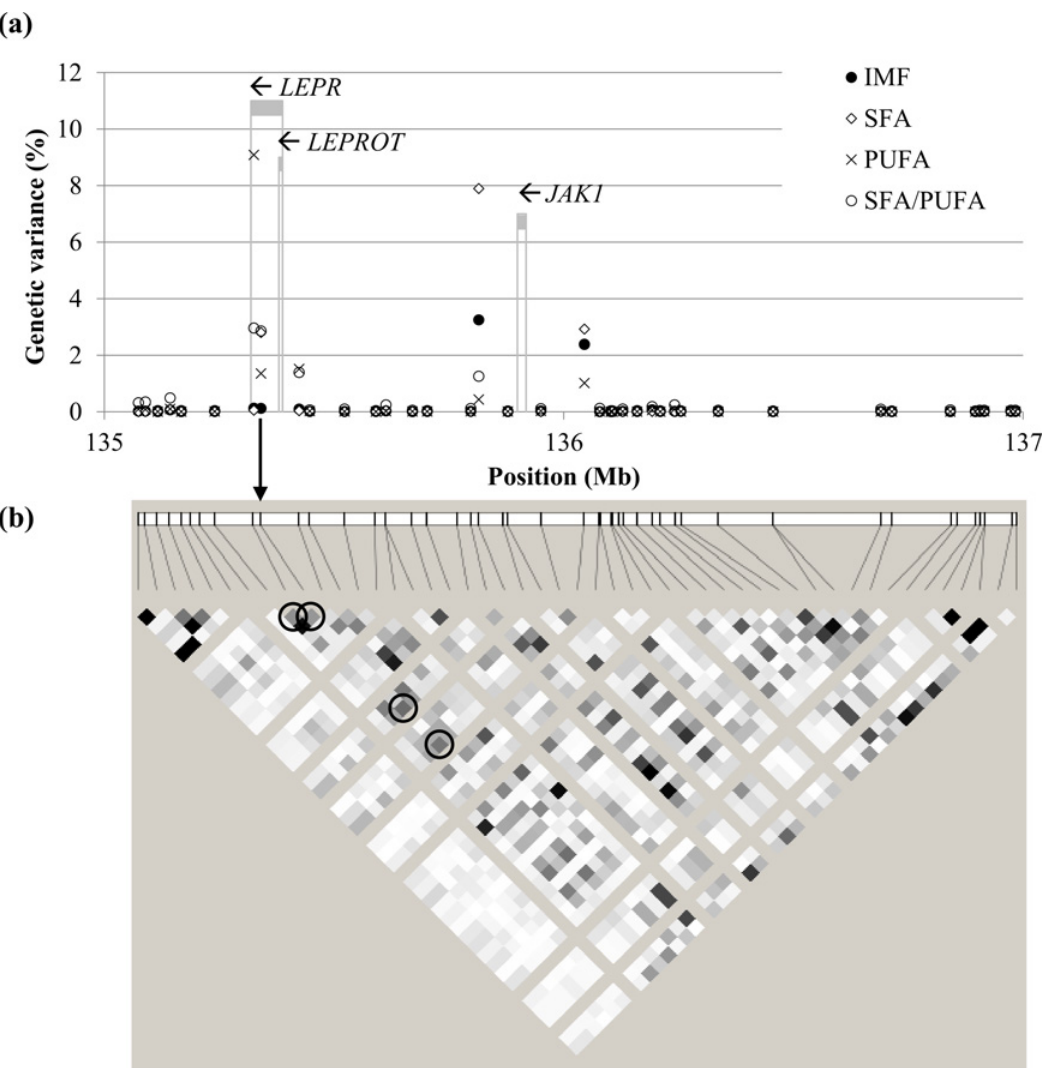
Fig 4. Individual markers in the SSC6 at 135 – 137 Mb region. Panel (a) shows the percentage of genetic variance explained for intramuscular fat content (IMF), saturated fatty acids (SFA), polyunsaturated fatty acids (PUFA), and SFA/PUFA of muscle gluteus medius . The SNP NM_001024587: c . 1987C > T in exon 14 of LEPR , indicated with an arrow, is not provided in the chip. Grey stripes indicate the location of candidate genes LEPR (tentative), LEPROT , and JAK1 , and arrows indicate sense of transcription. Panel (b) shows the linkage disequilibrium in the region (white: r 2 = 0; black: r 2 = 1). The SNP c . 1987C > T is in high linkage disequilibrium with the four SNPs picking up the strongest signals (circled; from left to right: ASGA0089937, ASGA0093565, ALGA0037129, and